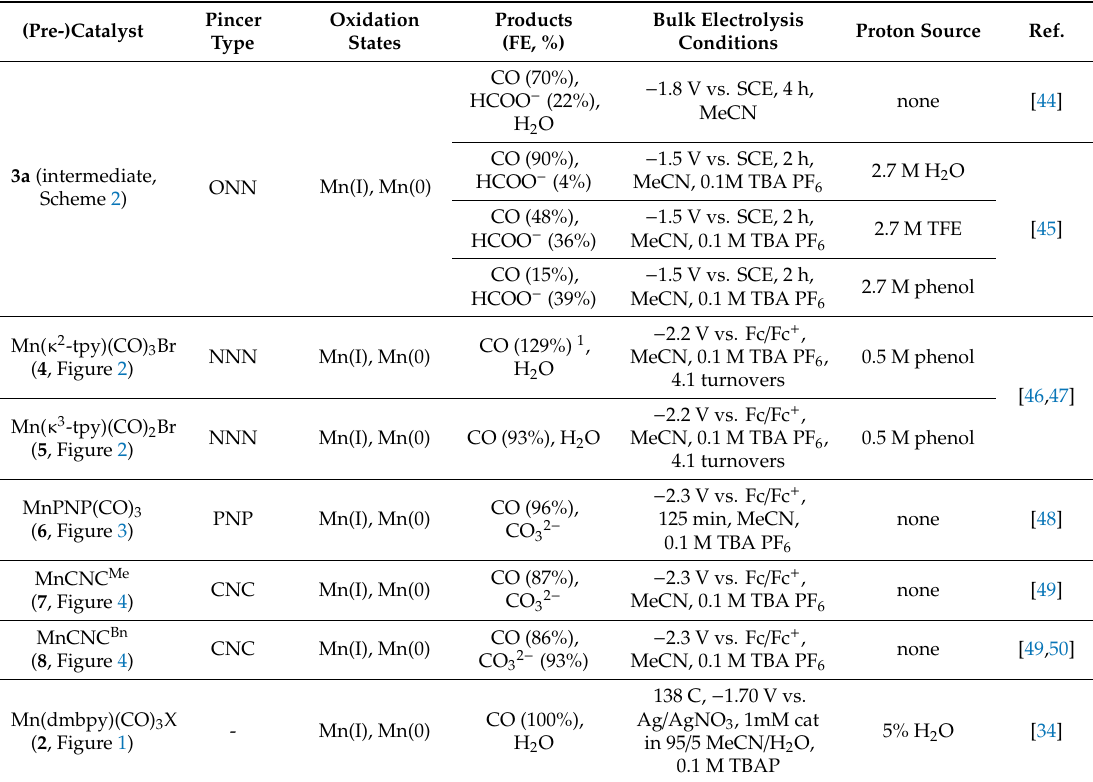
Table 1. Summary of pincer catalysts